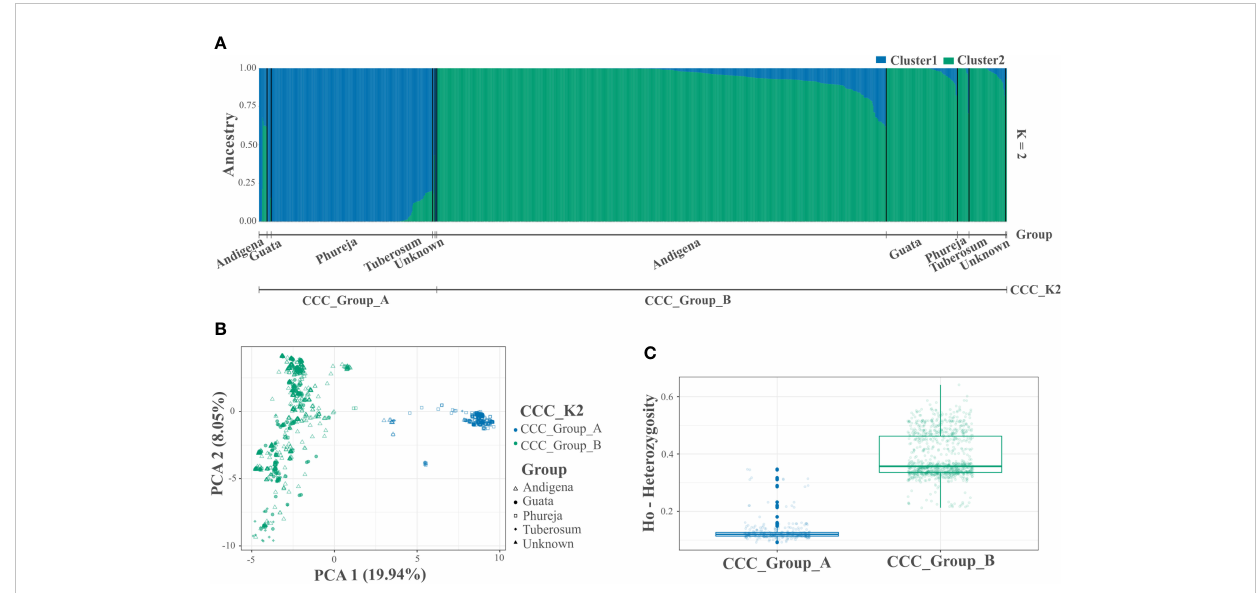
FIGURE 1 Population structure and genetic diversity analyzes of the Colombian Central Collection (CCC) of potatoes for two genetic groups (CCC_K2). (A) Bar plot of genetic structure analysis for two genetic groups (K=2) identi fi ed using the STRUCTURE software and designated as CCC_Group_A and CCC_Group_B (lower line). The AGROSAVIA in-house classi fi cation (Group) is indicated in the upper line (Andigena, Phureja, Tuberosum, “ Guata ” and Unknown), (B) Scatter plot of the Principal Component Analysis (PCA) color coded by genetic group and shaped following AGROSAVIA in-house biological status classi fi cation (Group), and (C) Box plot with distribution (box representing the second and third quartiles, line across the median, and vertical line the range of data) with distribution of observed heterozygosity (Ho) for each genetic group.